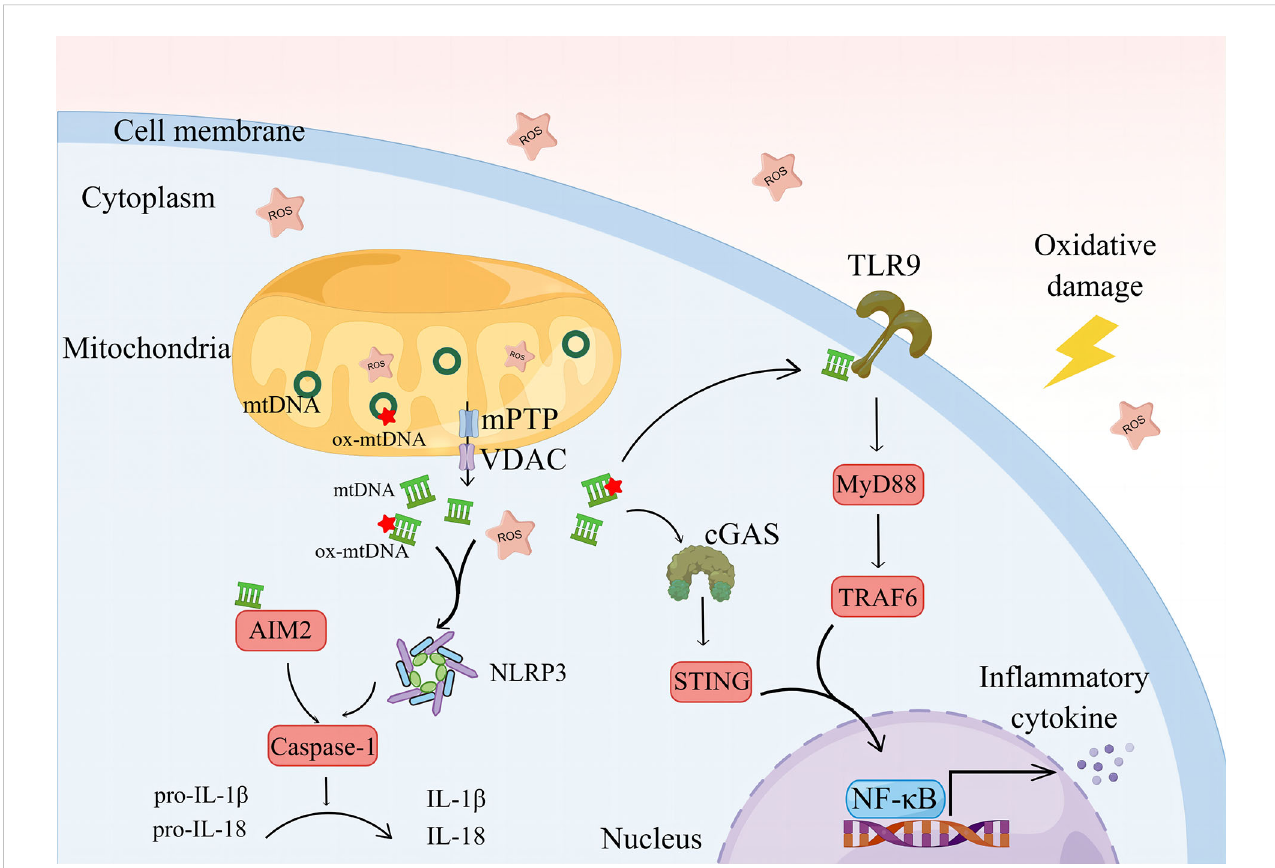
FIGURE 2 The oxidative damage environment and ROS cause mitochondrial damage, prompting mtDNA leakage and a further increase in ROS. mtDNA is oxidized by ROS to form ox-mtDNA, co-activating NLRP3 and prompted casape-1 maturation, activated IL-1 b and IL-18. The cytoplasmic mtDNA can be recognized by AIM2, mediating the activation of AIM2 and promoting the cleavage of casape-1, mediating the in fl ammatory response. By recognizing the free mtDNA, cGAS activates the STING/NF- k B pathway in the cytoplasm.NLRP3, NOD-like receptor protein 3. IL-1 b , interleukin-1 b . IL-18, interleukin-18. AIM2, Absent in melanoma-2; cGAS, cyclic GMP-AMP synthase; STING, stimulator of interferon genes; TLR9, Toll-like receptors 9; MyD88, myeloid differentiation factor 88; TRAF6, TNF receptor associated factor 6; NF- k B, nuclear factor kappa-B. By